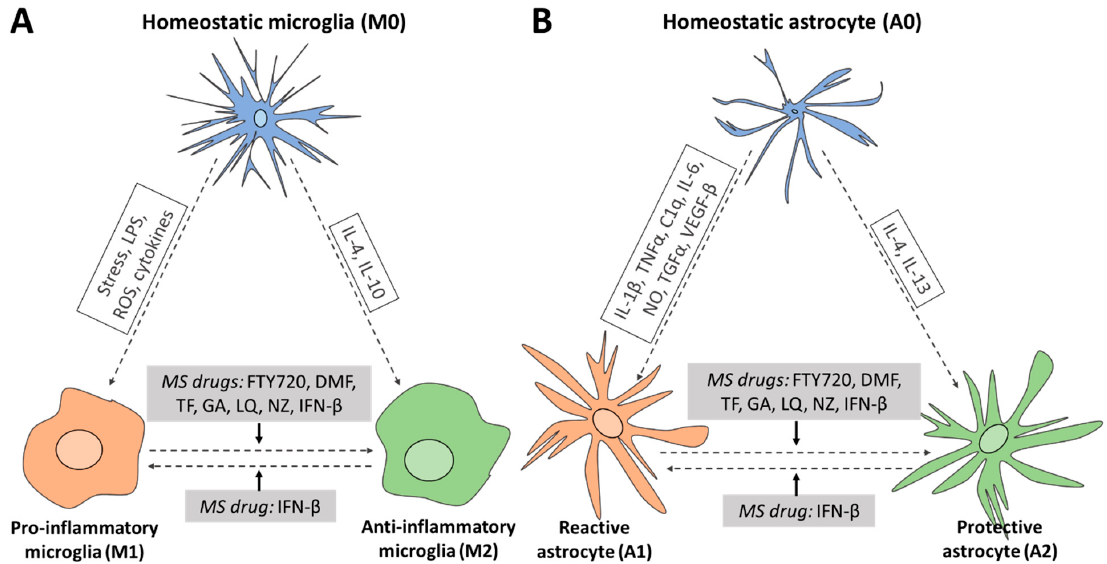
Figure 1. Effects of the environmental cues and the FDA-approved multiple sclerosis (MS) drugs on ( A ) the homeostatic M0 microglia becoming pro-inflammatory microglia (M1) or the anti-inflammatory microglia (M2) and ( B ) the homeostatic A0 astrocytes becoming reactive astrocytes (A1) or neuroprotective astrocytes (A2). Black dotted arrows indicate a change in phenotype. Black solid arrows indicate influence of MS drug on the change in phenotype. FTY720: Fingolimod, DMF: Dimethyl Fumarate, TF: Teriflunomide, GA: Glatiramer Acetate, LQ: Laquinimod, NZ: Natalizumab, IFN- β : Interferon- β .